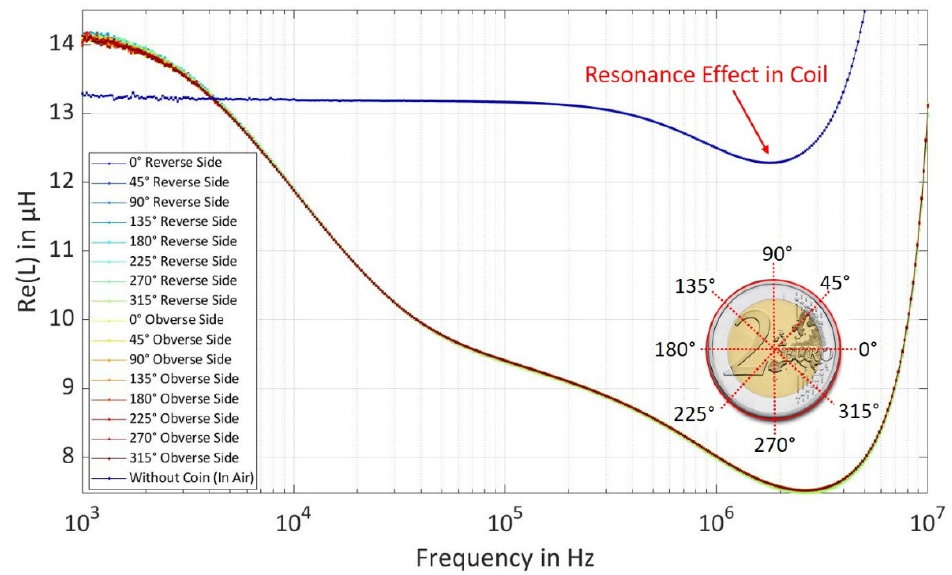
Figure 3. Measured Inductance Spectra of EUR 2 Coin using Reverse and Obverse Side at different Rotating Angles from 0° to 360° Spanned each at 45°.